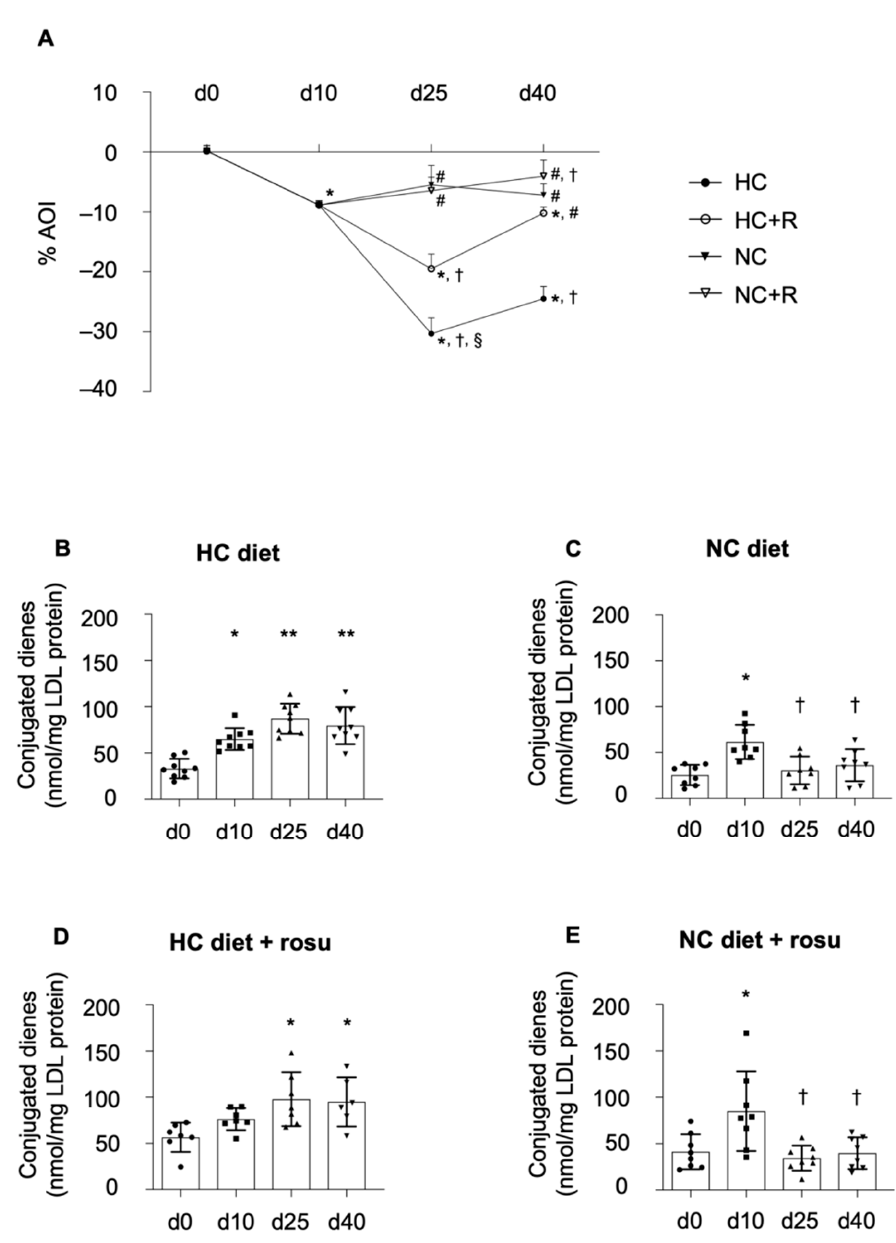
Figure 3. Effects of diet and rosuvastatin intervention on HDL antioxidant capacity. Changes in HDL antioxidant capacity are presented as percent antioxidant index (( A ), % AOI; measure for capacity to reverse LDL oxidation) and levels of conjugated dienes (( B – E ) product of lipid oxidation). Data are shown as mean ± SEM (( A ); for visual clarity of the graph) or SD (whiskers) over the period of 40 days. ( A ) includes all four groups, whereas ( B – E ) represent each group individually. Shapiro–Wilk test confirmed normality (alpha = 0.05), and data were analyzed by one-way ANOVA with Tukey’s multicomparison test and considered significant with a p -value < 0.05. For ( A ): * p < 0.05 in comparison to day 0; † p < 0.05 in comparison to day 10; # p < 0.05 compared to HC; § p < 0.05 in comparison to NC. For ( B – E ): * p < 0.05, ** p < 0.0001 in comparison to day 0; † p < 0.05 in